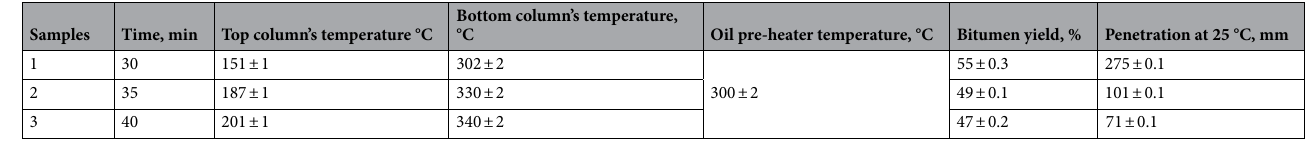
Table 1. Experimental parameters of steam distillation of heavy oil for non-oxidized bitumen.